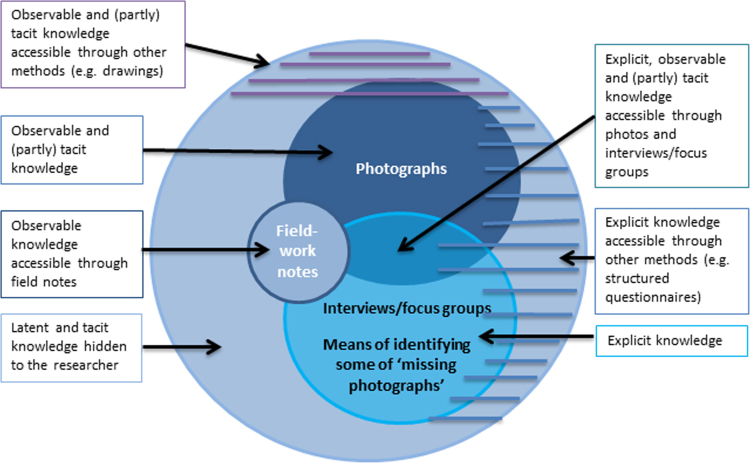
Conceptualisation of the different levels of knowledge that can be accessed through photovoice methods. Adapted from Visser et al. (2005).